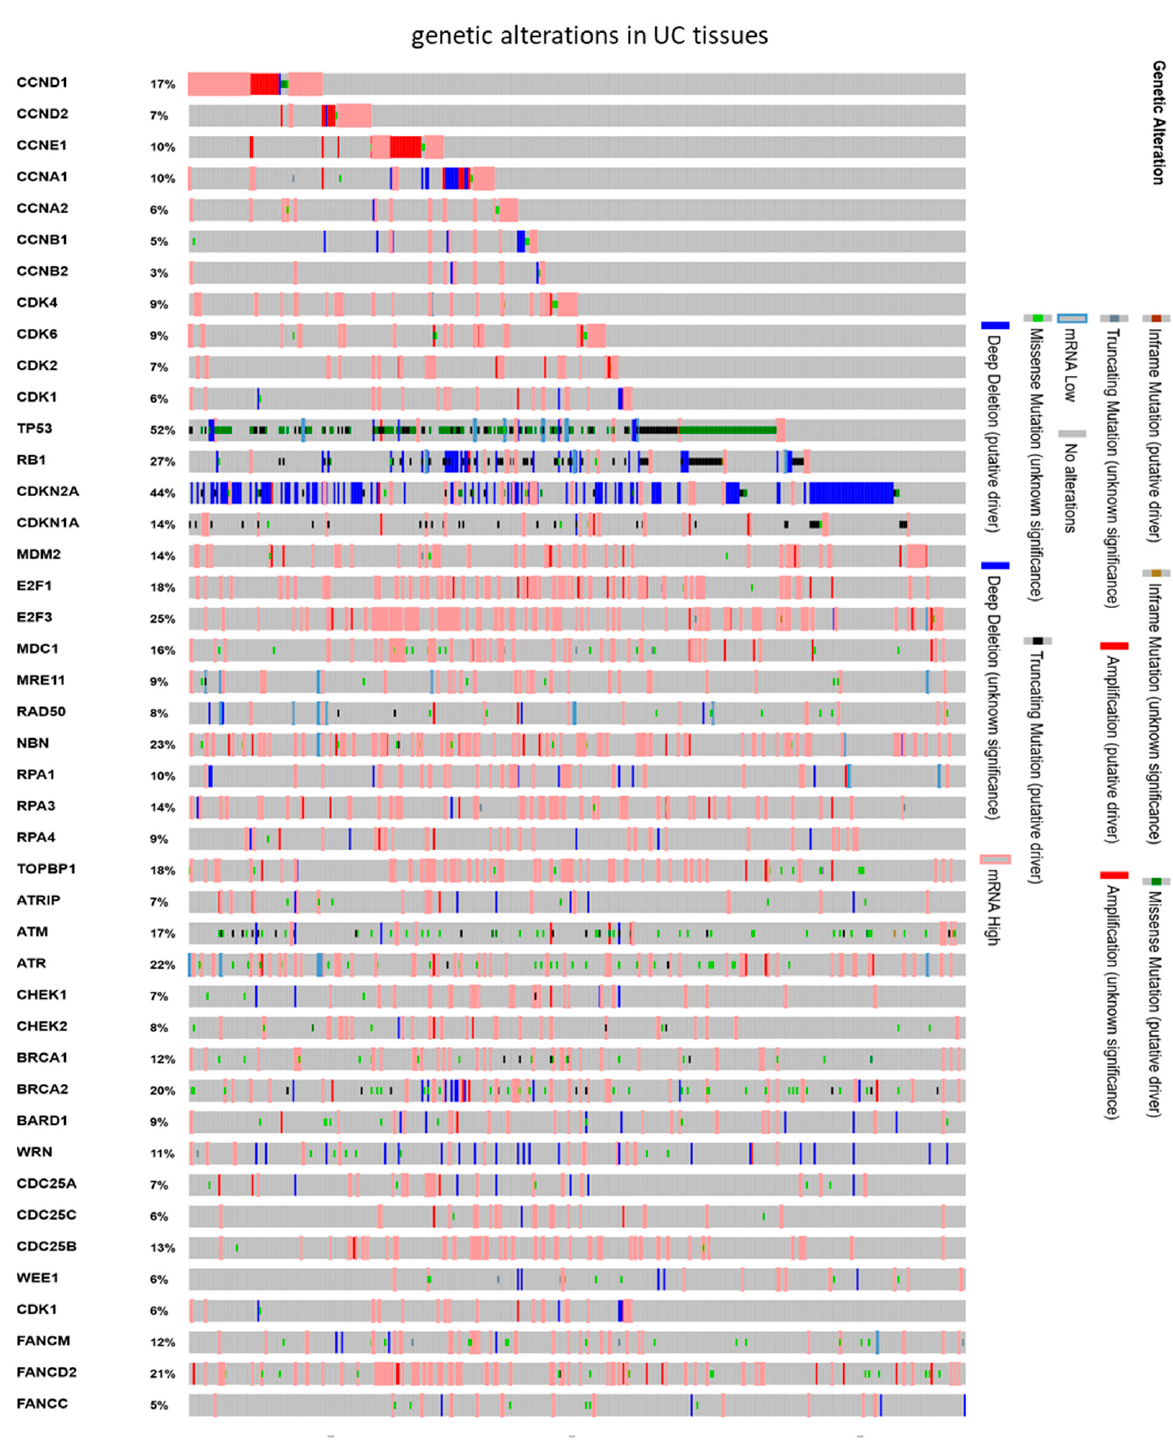
Figure 1. Genetic alterations of cell cycle and checkpoint control genes in UC tissues. Public TCGA data was queried for the BLCA set ( n = 413; [37] ) by means of the oncoprint tool provided by the cBioPortal database.